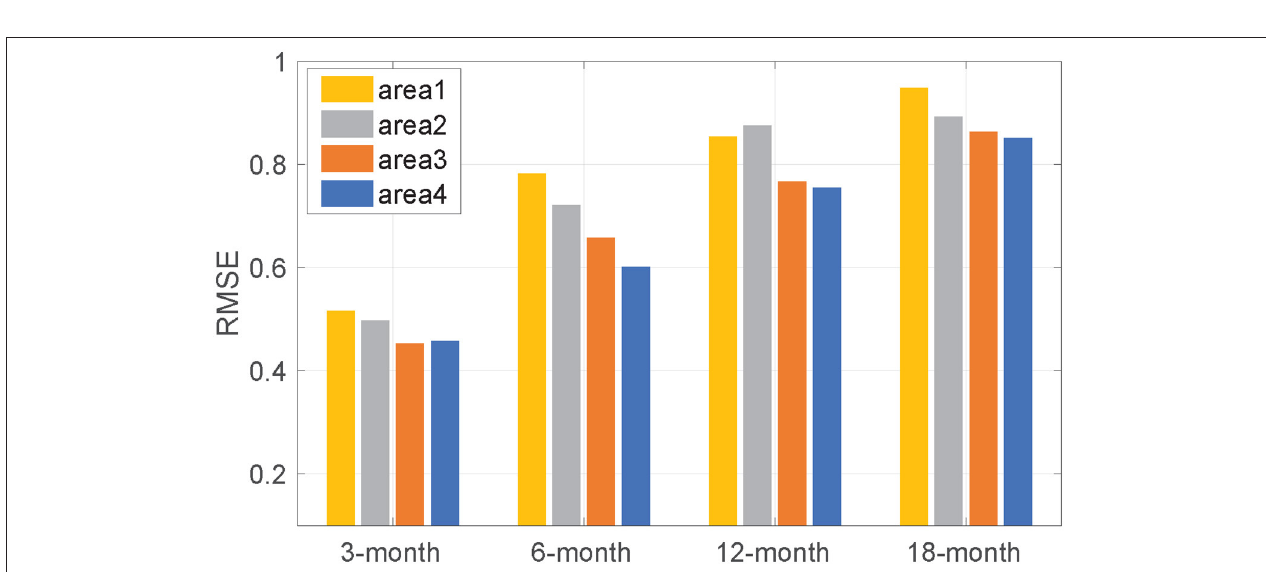
FIGURE 5 | Root Mean Square Error between predicted values and actual values with different input sizes. Refer to Figure 4 for the information of the area1, 2, 3, 4.